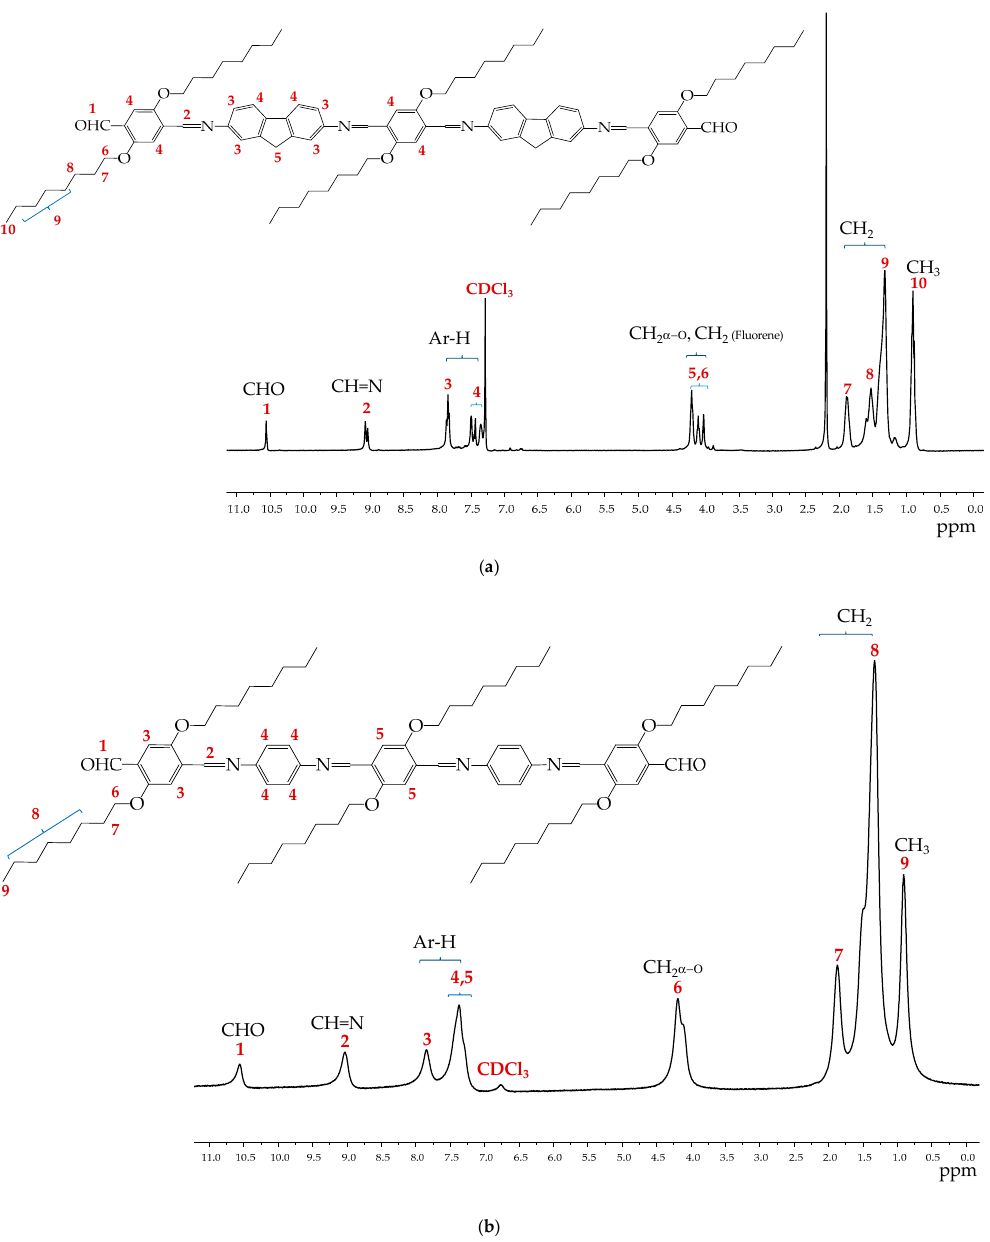
Figure 3. NMR- 1 H spectra in CDCl 3 of the oligophenyleneimines: ( a ) DAFCHO; and ( b ) FDACHO.